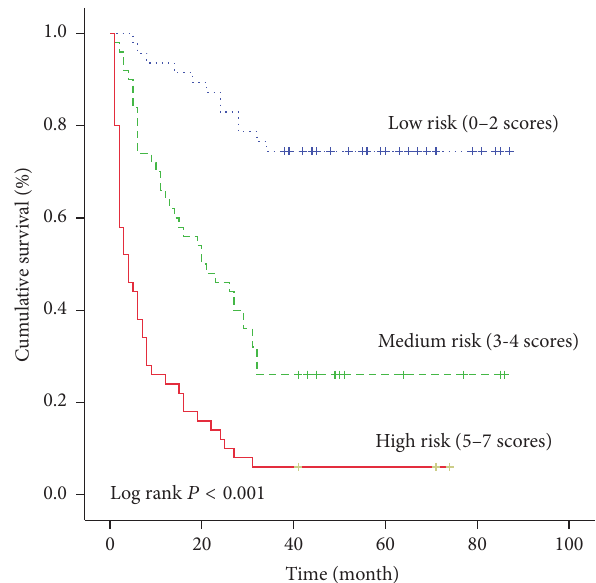
Figure 7: The cumulative survival rate of patients in different risk